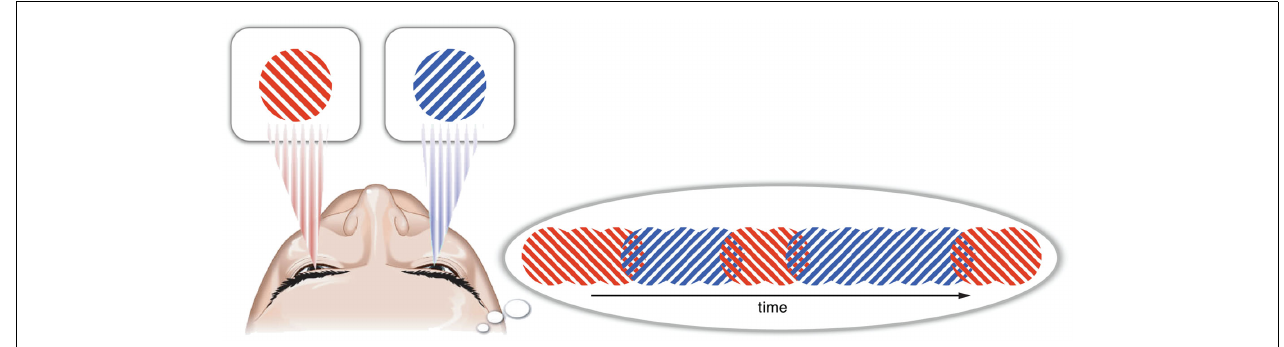
FIGURE 1 | Binocular rivalry occurs when different images are presented, one to each eye. In this situation, observers do not perceive a blend of the two stimuli, but instead experience irregular perceptual alternations between the two images such that only one image is typically perceived at a time. Head image courtesy of Jamie